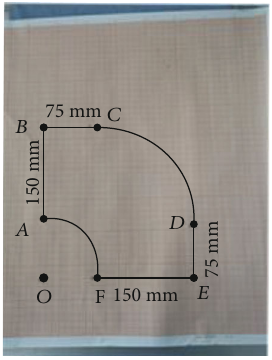
Figure 25: The workspace formed by connecting